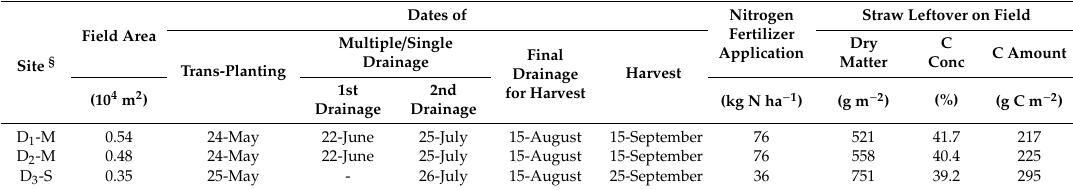
Table 2. Summary of management practices of the investigated paddy